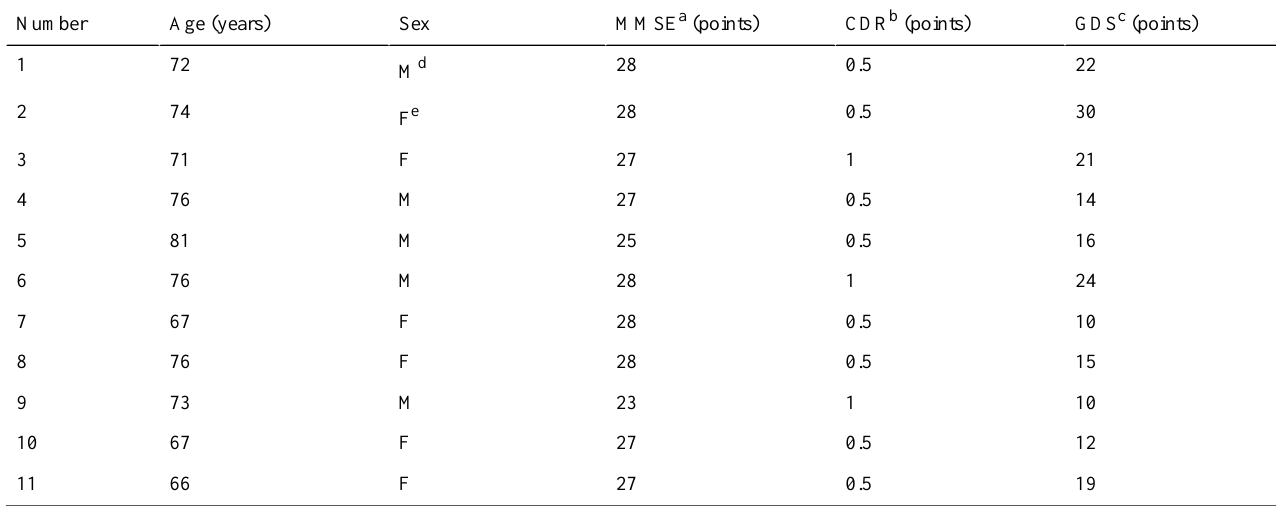
Table 2. Patients’demographics and baseline characteristics